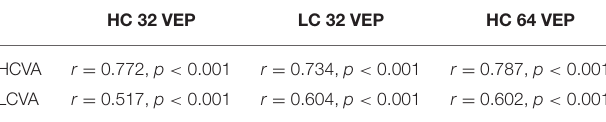
TABLE 4 | Correlation between VA and VEP latency according to contrast and check